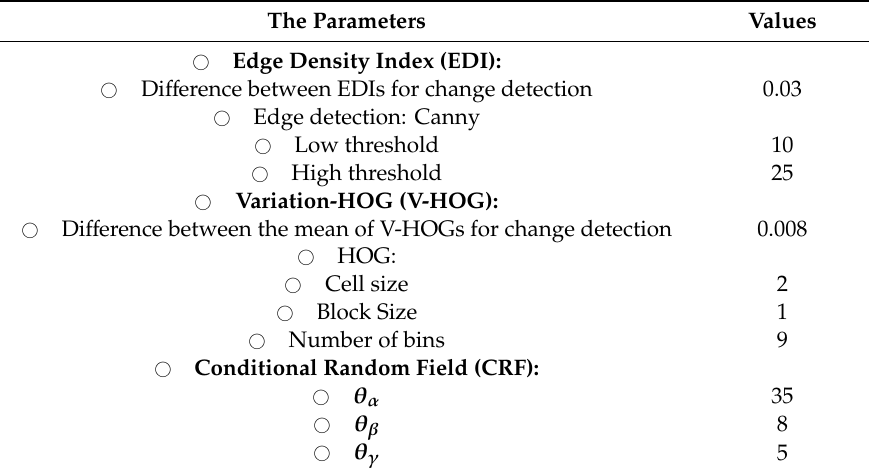
Table 2. The parameters and threshold values used to do the